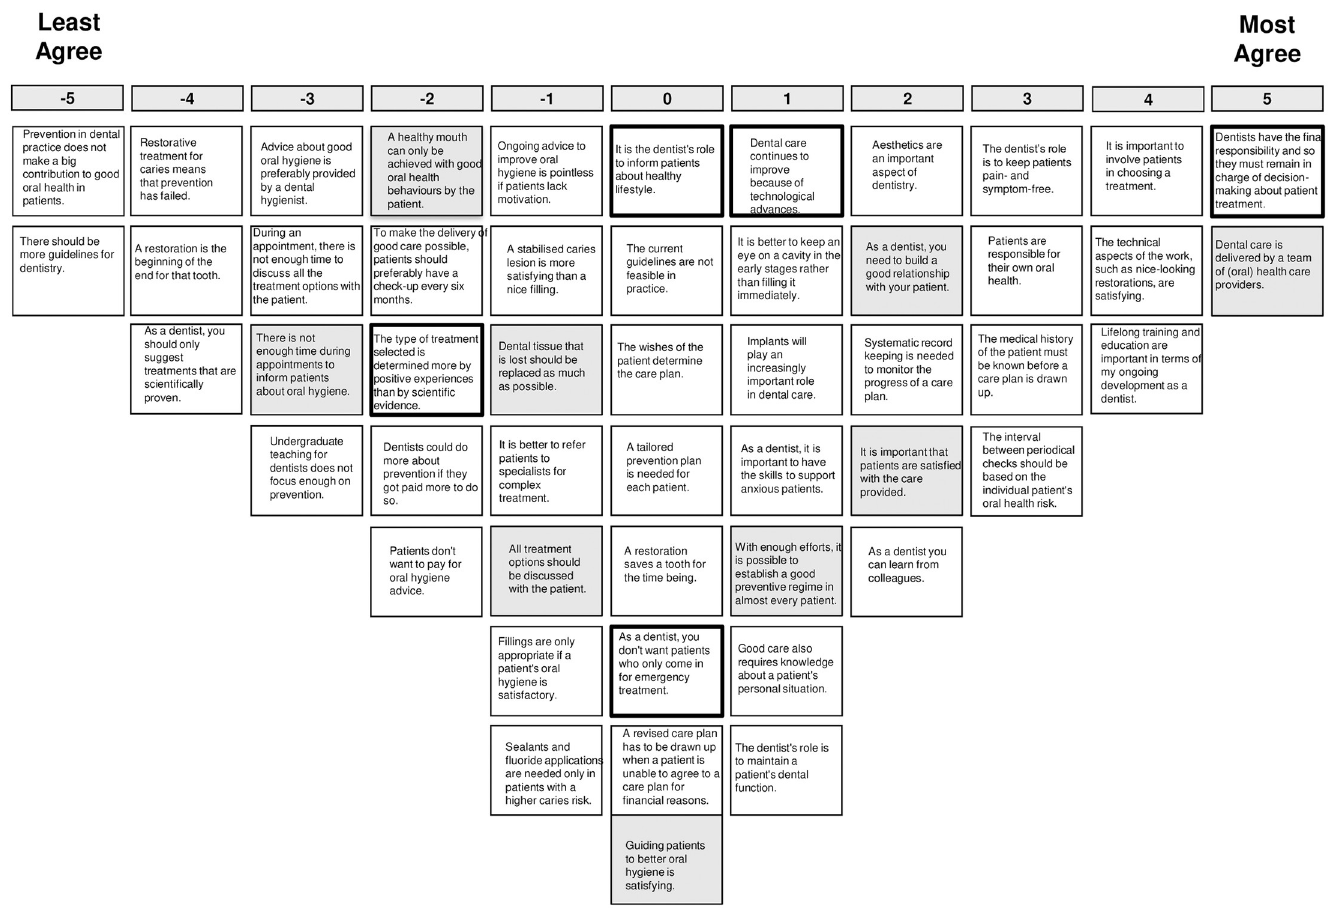
Fig 4. Score sheet for viewpoint 3. Note: Distinguishing statements (p < 0.05) are shown in black outlined boxes, distinguishing statements (p < 0.001) are shown in grey boxes.